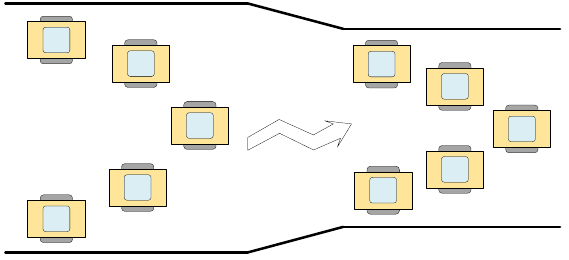
Figure 3. Schematic diagram of dynamic adjustment of the formation.